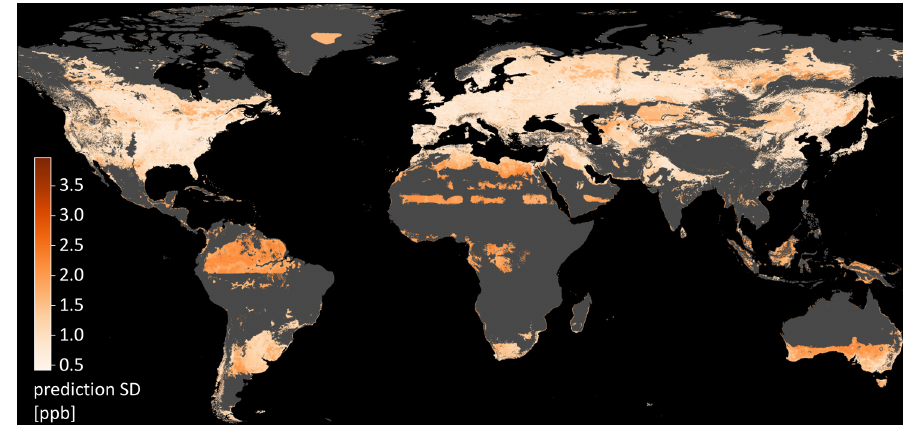
Figure 7. Standard deviation of the ozone predictions under perturbations. This map was created by stacking the maps of 100 error model realizations along the z axis and then calculating the grid point-wise standard deviation along the z